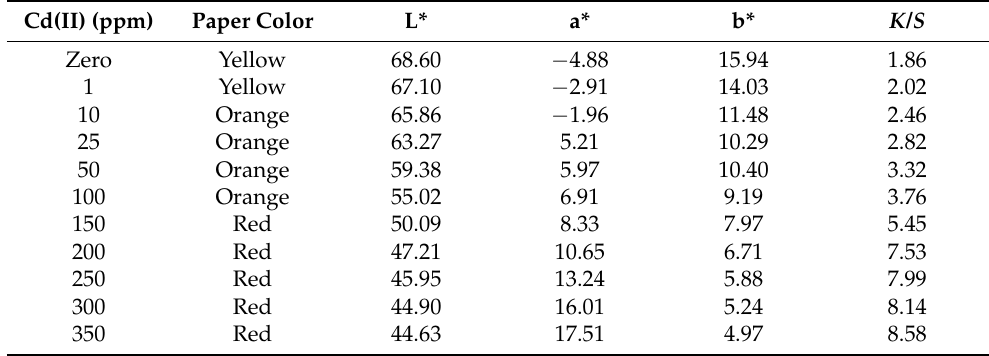
Table 3. Colorimetric screening of test dipstick at various cadmium concentration levels.